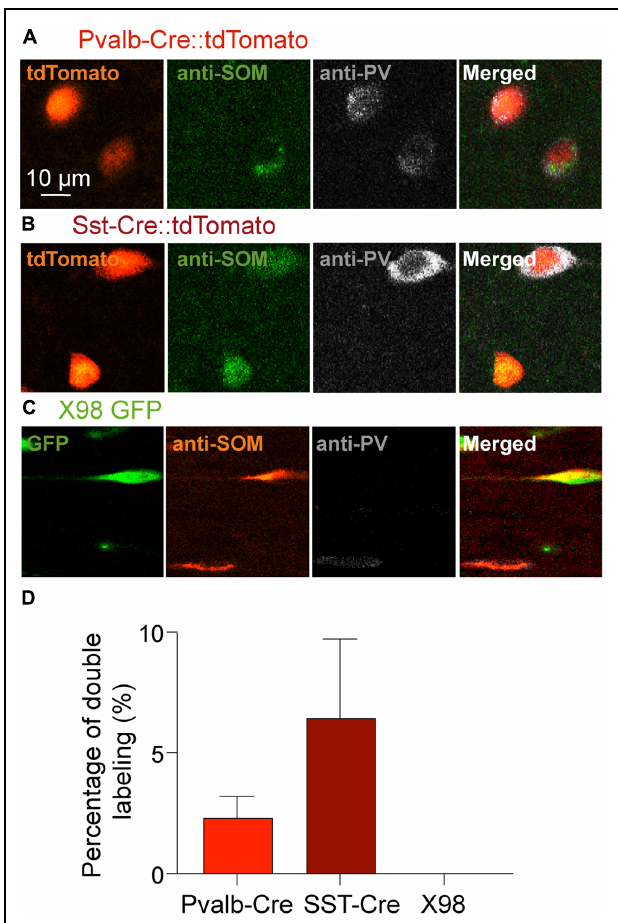
FIGURE 4 | Double immunostaining of mouse presubicular sections for PV and SOM. Staining of tissue from (A) Pvalb-Cre tdTomato, (B) Sst-Cre tdTomato and (C) X98 GFP animals with antibodies against SOM (green or red) and PV (gray). (A–C) show fluorescent signals from labeled neurons of each mouse line (left), immunostaining for SOM, for PV and a merged image (right). (D) 2% of Pvalb-Cre tdTomato + cells were immunopositive for both PV and SOM. 6% of Sst-Cre tdTomato + cells were positive for both PV and SOM. Co-marked cells were found in both deep and superficial layers. Since X98 GFP + cells were never immunopositive for PV, there was no